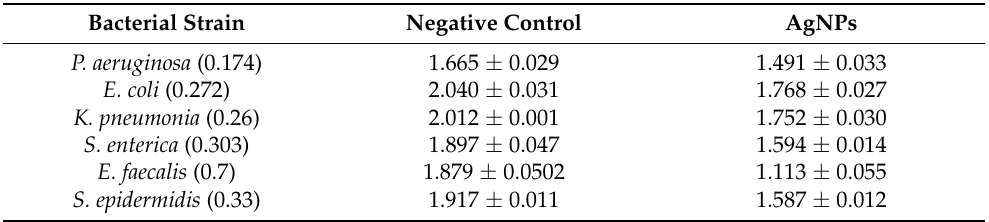
Table 3. The ODs results for P. aeruginosa , E. coli , K. pneumonia , S. enterica , E. fecalis , and S. epidermidis , after 24 h of incubating at 37 ◦ C with the freshly prepared AgNPs and the negative control; without AgNPs. The quantification of the total number of bacteria was done in triplicate. Bacterial